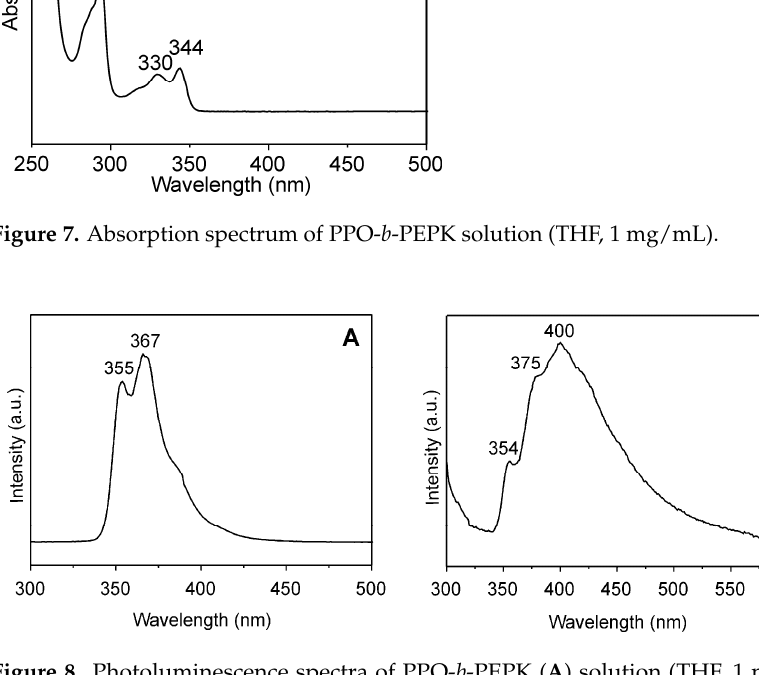
Figure 6. TGA ( A ) and DSC ( B ) curves of PPO- b -PEPK copolymer sample 2.